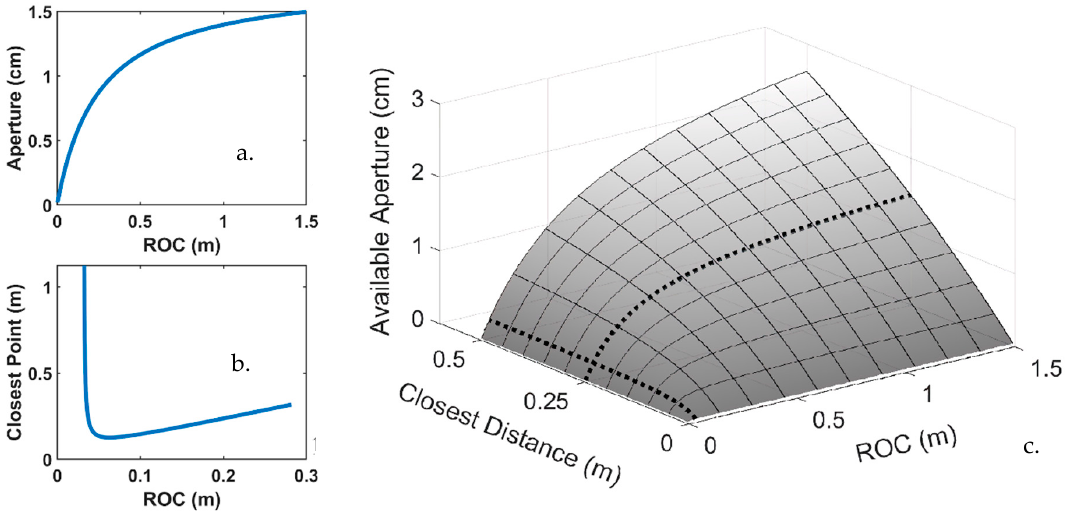
Figure 9. ( a ) The largest aperture allowed for the device is displayed here with respect to the radius of curvature (when θ MAX = 2 ◦ ). The closest point the display can focus to is held at 25 cm (from the eye). ( b ) The closest point d the display can focus to is displayed here with respect to the radius of curvature (when θ MAX = 2 ◦ ). The aperture size (created by the active region of the device) is held at 2.2 mm. ( c ) Figures 6a and 10a are 2D cross-sections of this plot; they are shown as dashed lines. The intersection point is chosen for the preferred instantiation in Section 6.